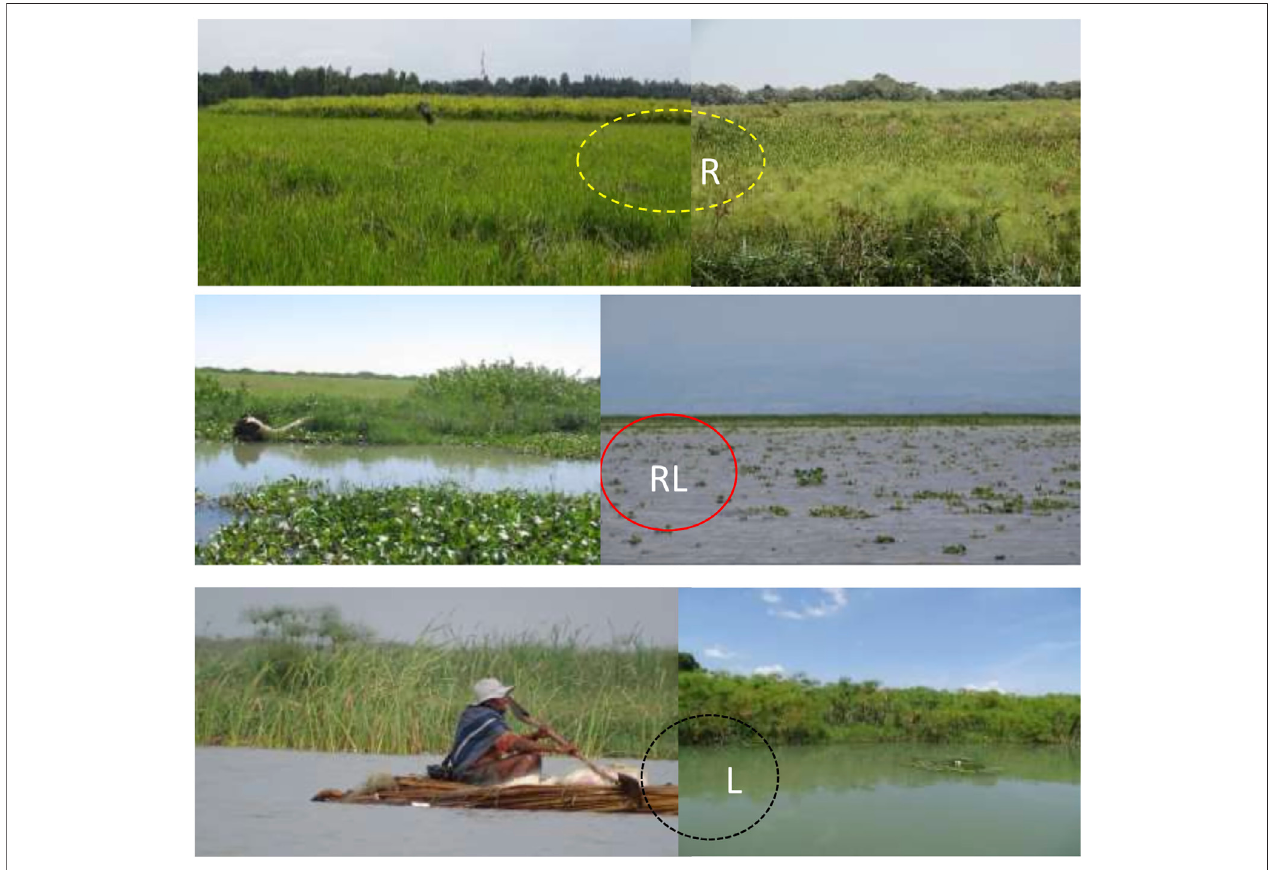
FIGURE 2 | Field pictures showing the typical habitats for riverine papyrus swamps (R), river mouth wetlands (RL), and lacustrine wetlands (L).